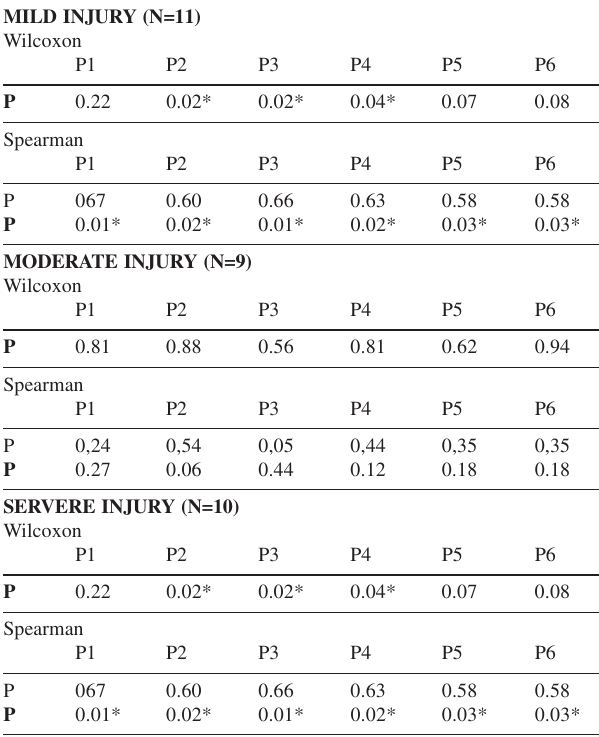
Table 1 - Evaluations of the right and left sides using wilcoxon’s test and evaluation of effective pairing using spearman’s one-tailed correlation test (alpha=